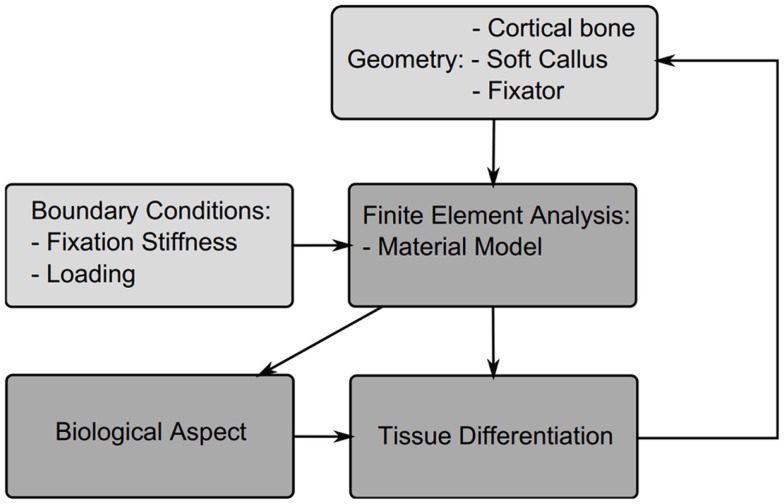
Structure of a typical fracture healing simulation. Initially a model is created consisting of the cortical bone fragments, soft callus, and the fixator. Material properties and boundary conditions are then applied to the model based on the tissue distribution and fixator properties, a finite element analysis is performed to determine the mechanicals stimuli, this then is used to drive cell proliferation and tissue differentiation, which updates the tissue distribution and thus new mechanical properties for the next iteration.